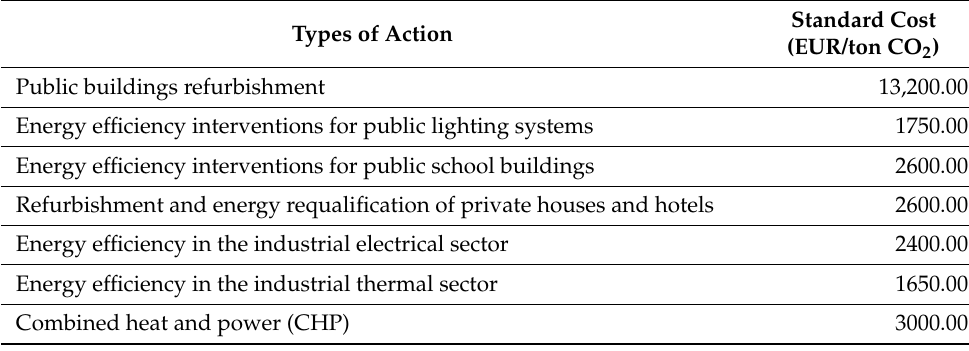
Table 4. The standard cost of